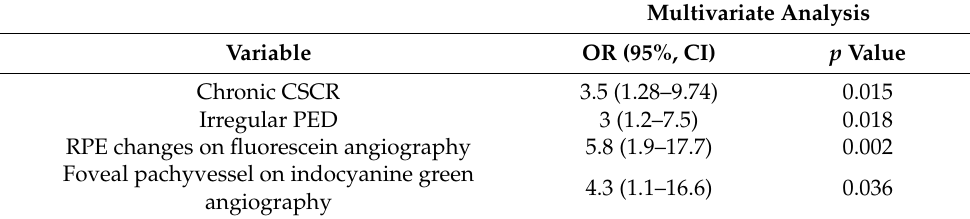
Table 3. Multiple Logistic Regression Analysis of factors associated with the presence of mid- phase hyperfluorescent plaques on indocyanine angiography in patients with central serous